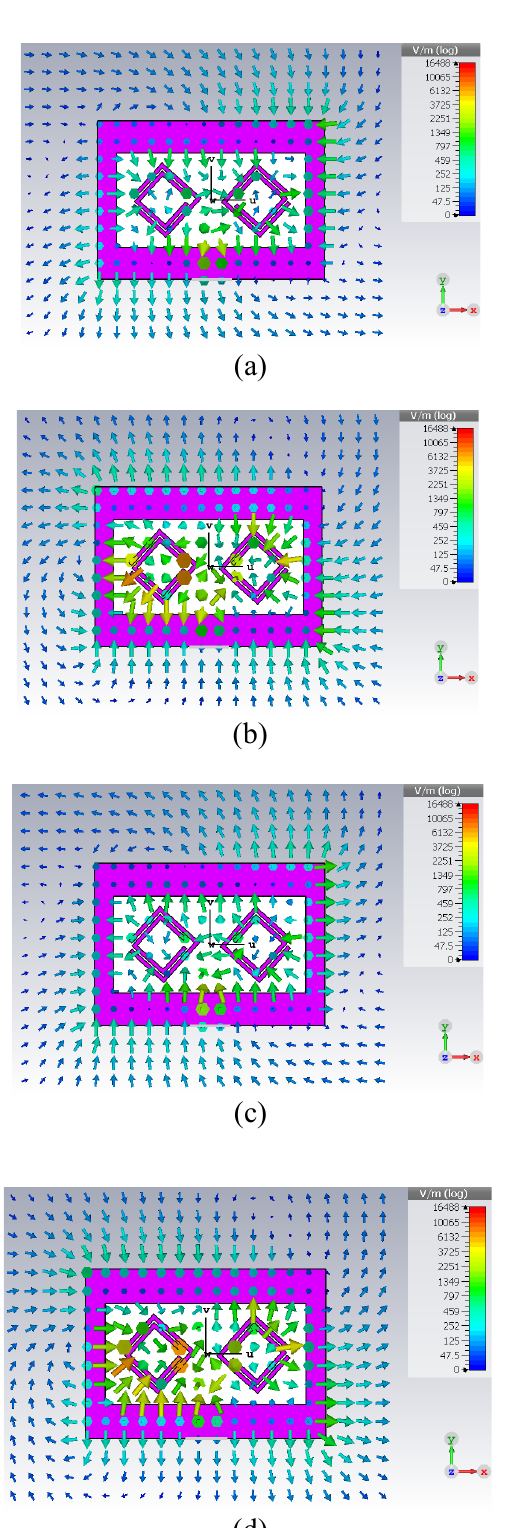
Figure 3: Simulated electric field distributions of the proposed slot antenna loaded with rotated square SRR at 2.45 GHz for different phase angles (a) ϕ = 0 0 (b) ϕ = 90 0 (c) ϕ = 180 0 (d) ϕ =270 0